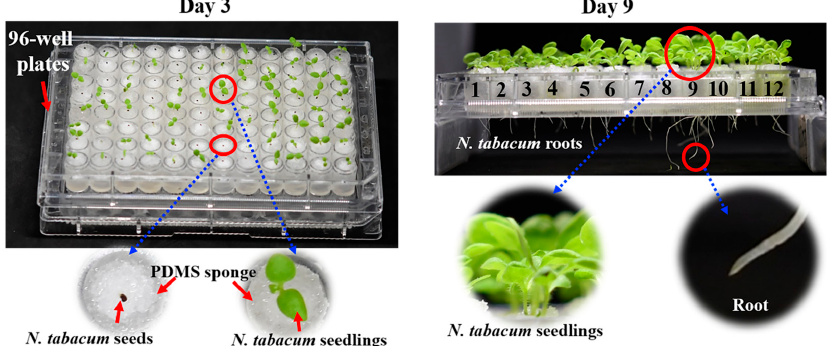
Figure 6. Growth of N. tabacum in 96-well microplate filled with PDMS sponges. Micro-well of columns 1–3, 4–6, 7–9, and 10–12 filled with PDMS sponges prepared from a PDMS: CAM ratio of 1:1, 1:2, 1:3, and 1:4, respectively.